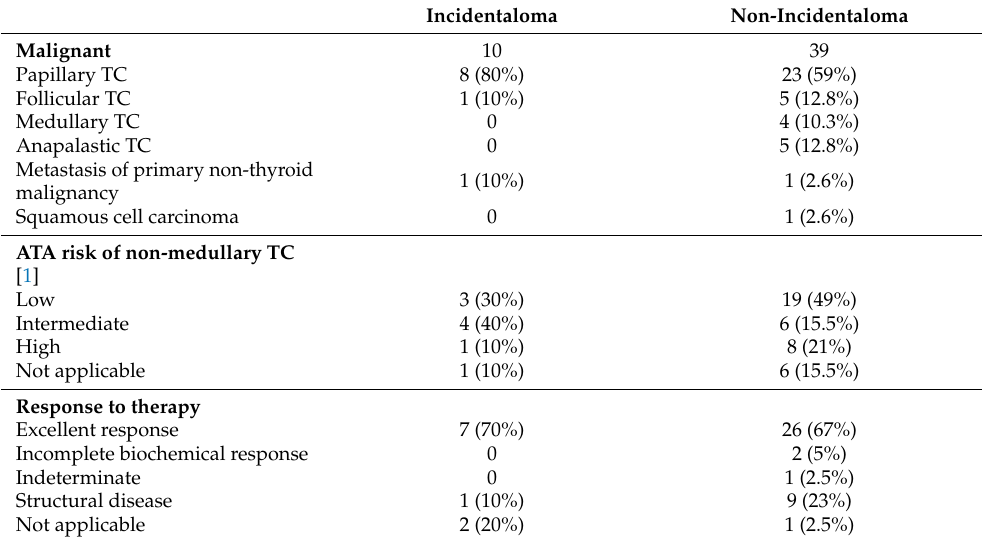
Table 2. Clinical characteristics of patients with malignant tumors. TC: thyroid